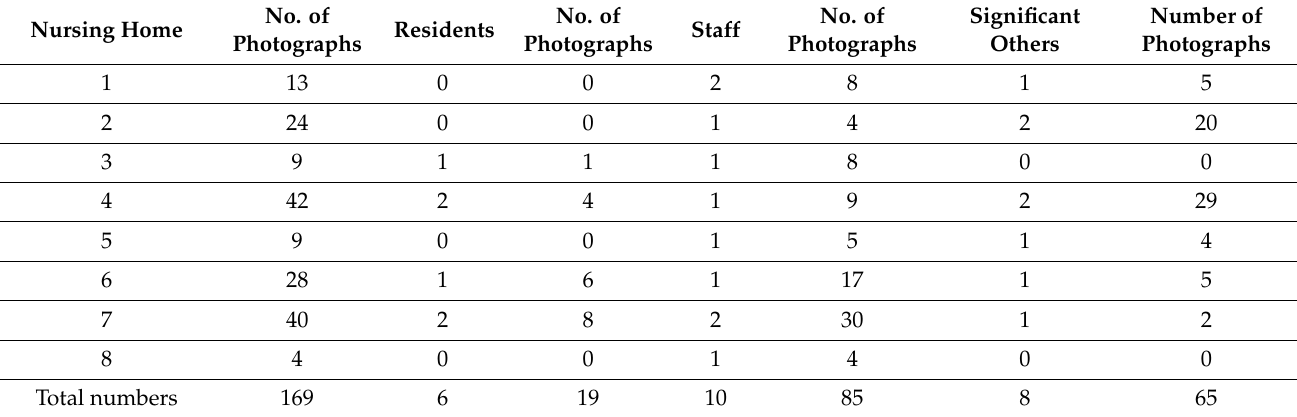
Table 1. Overview of number of photographs taken per home and by the different perspectives.